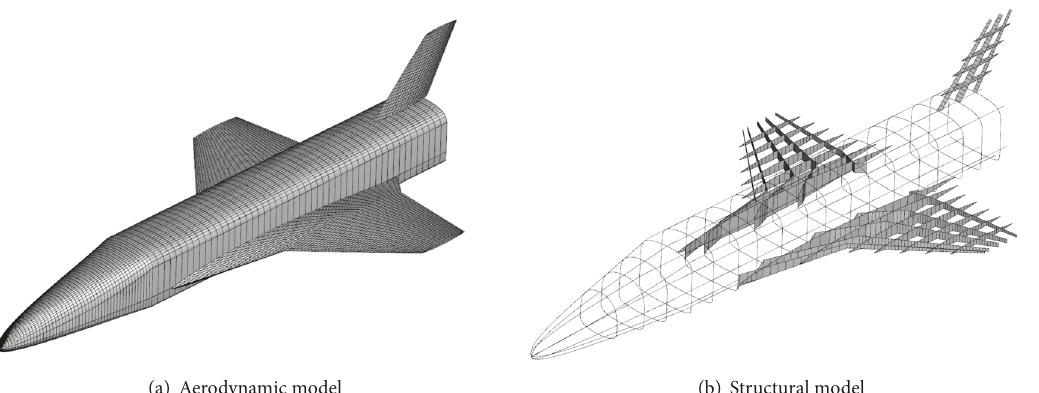
Figure 10: The aerodynamic model and the structural model of the RLV.